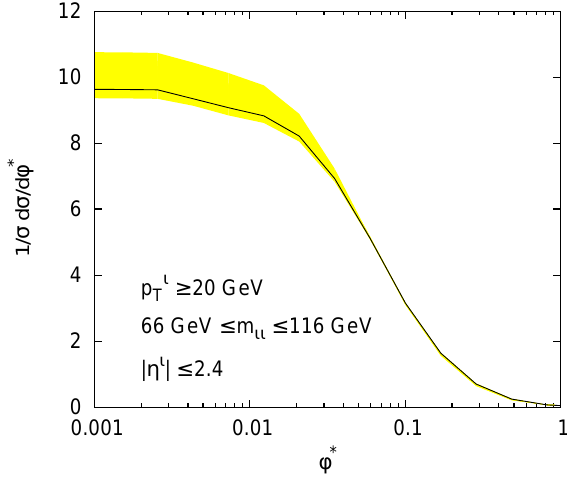
Figure 2. The theoretical NNLL + NLO prediction [26] for the φ ∗ distribution at the LHC ( √ s = 7